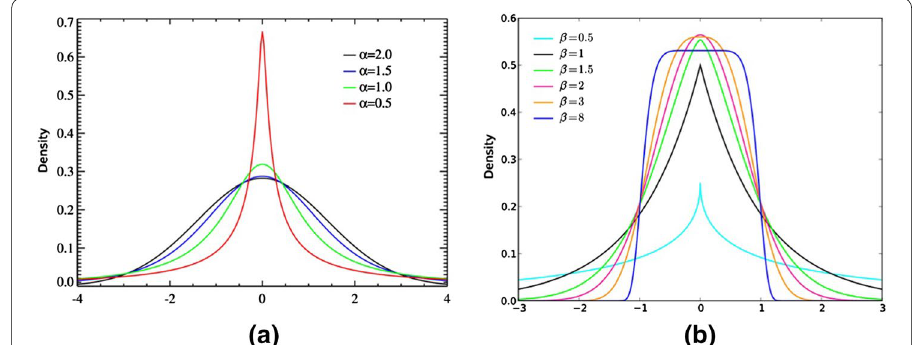
0, b various values for β / α = =